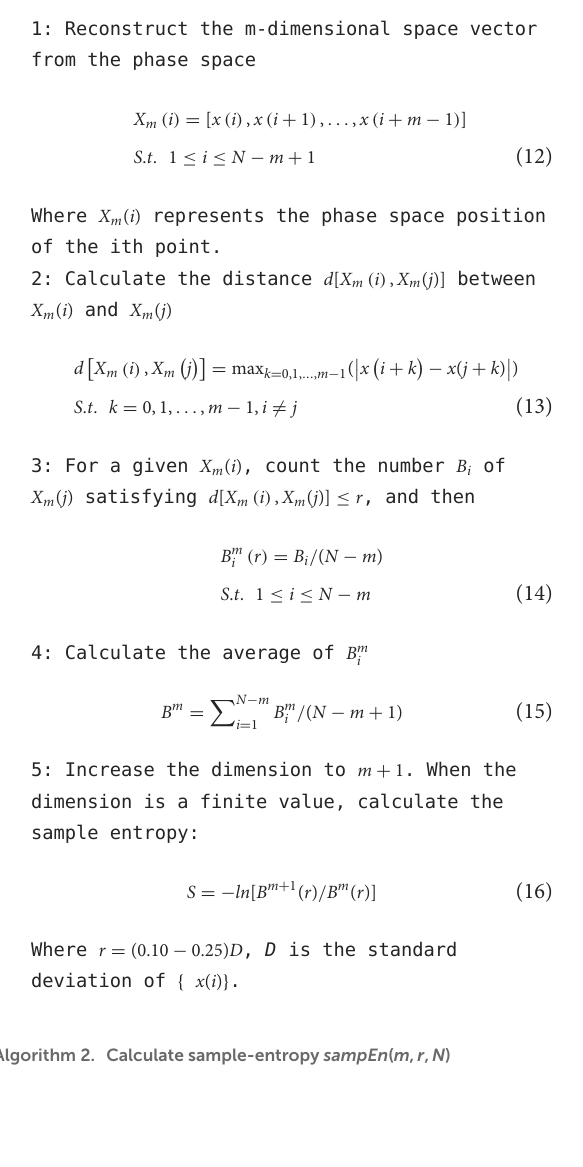
Algorithm 2. Calculate sample-entropy sampEn ( m , r , N